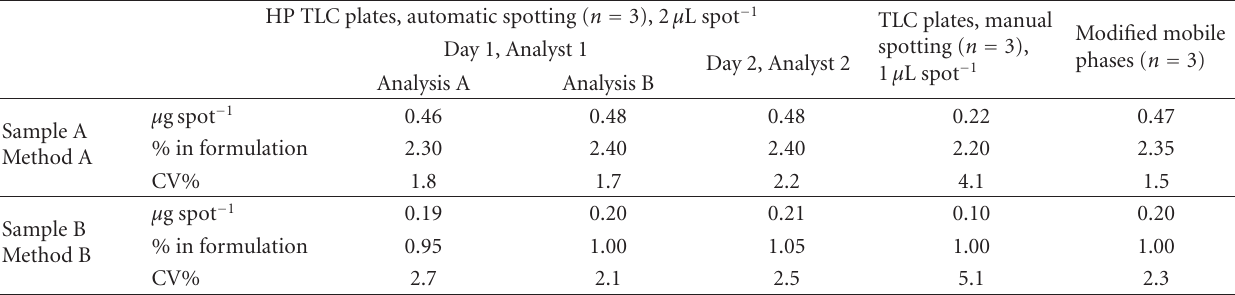
Table 2: Results of repeatability, intermediate precision, and robustness tests.